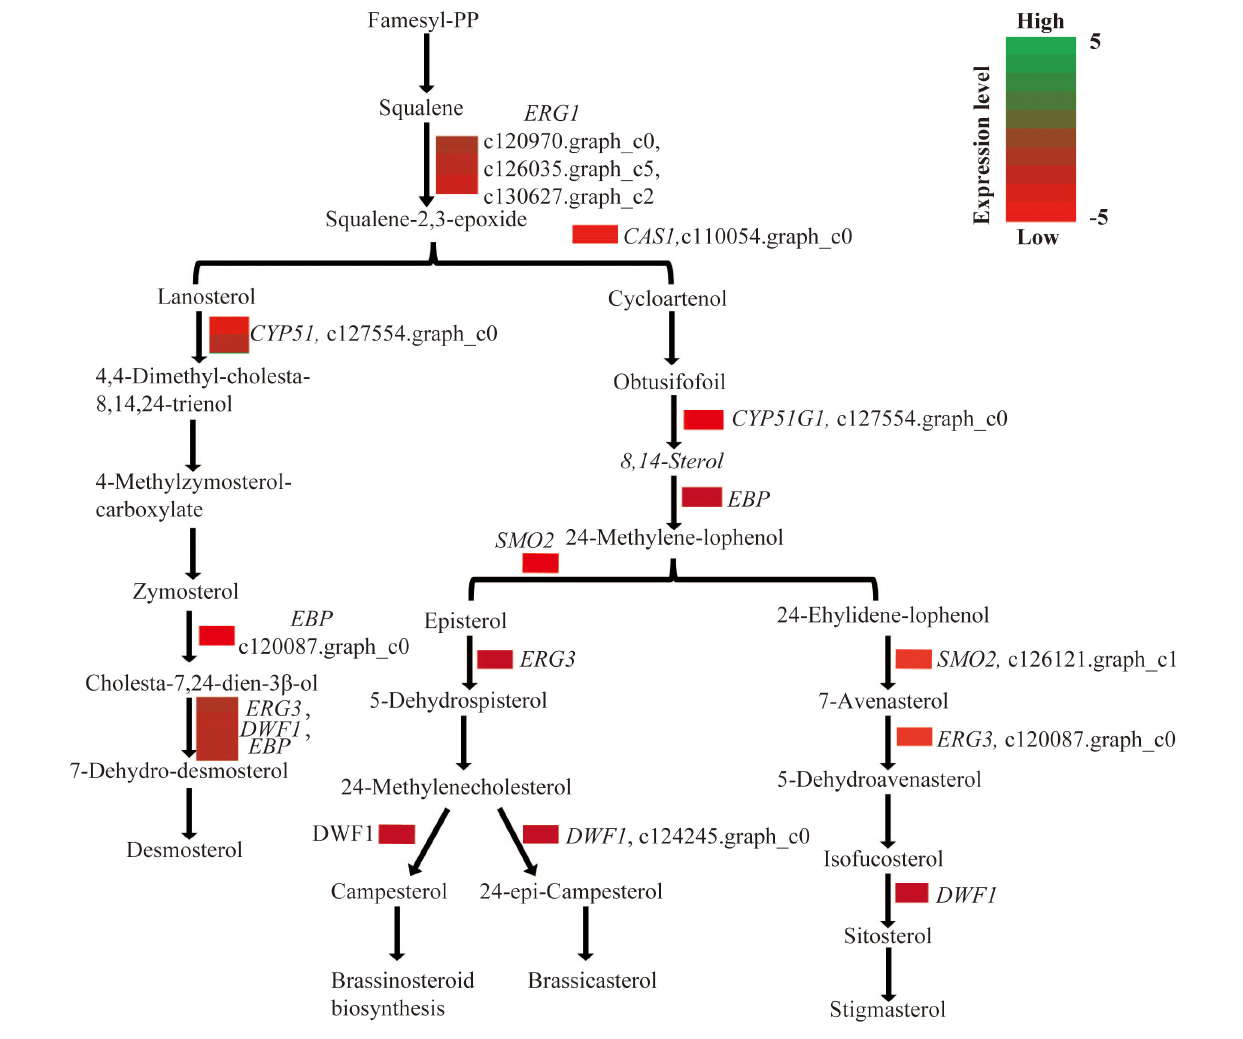
5-desaturase), and DWF1 (sterol reductase), which are all involved in steroid biosynthesis, were repressed in white vs.